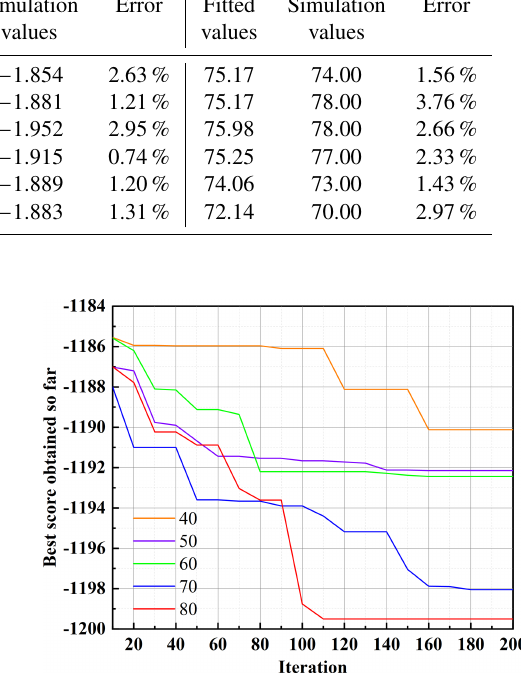
Figure 16. Effect of changing the number of populations on the calculation